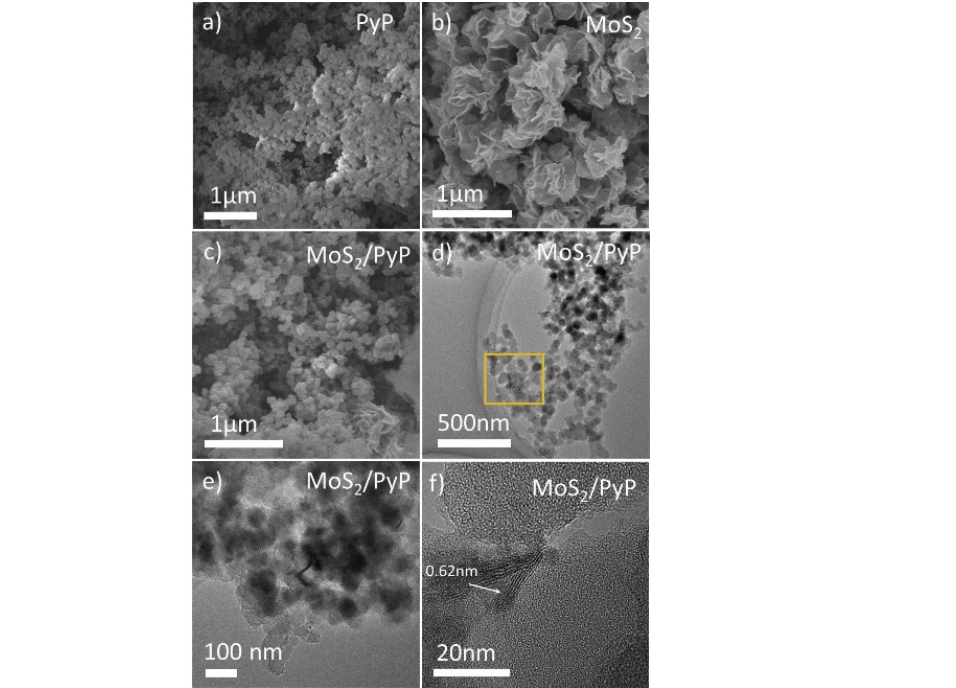
Figure 23. SEM images of ( a ) pure PyP, ( b ) MoS2 ( c ) 3 wt. % MoS2/PyP(IM) samples; ( d – f ) TEM images of 3 wt. % MoS 2 /PyP(IM) samples.